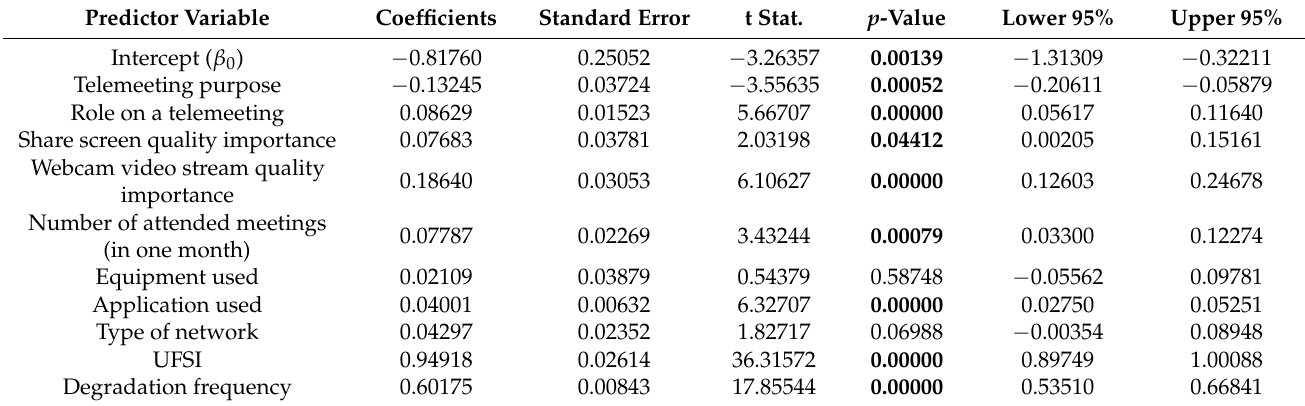
Table 13. Regression coefficients analysis for video is blocky degradation.